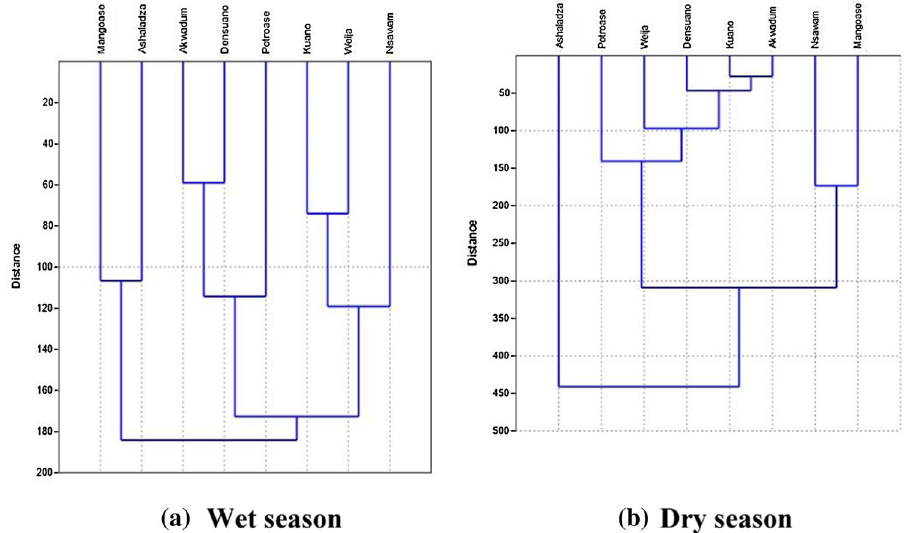
Fig. 9 Dendogram showing clustering of sampling stations Densu river water quality